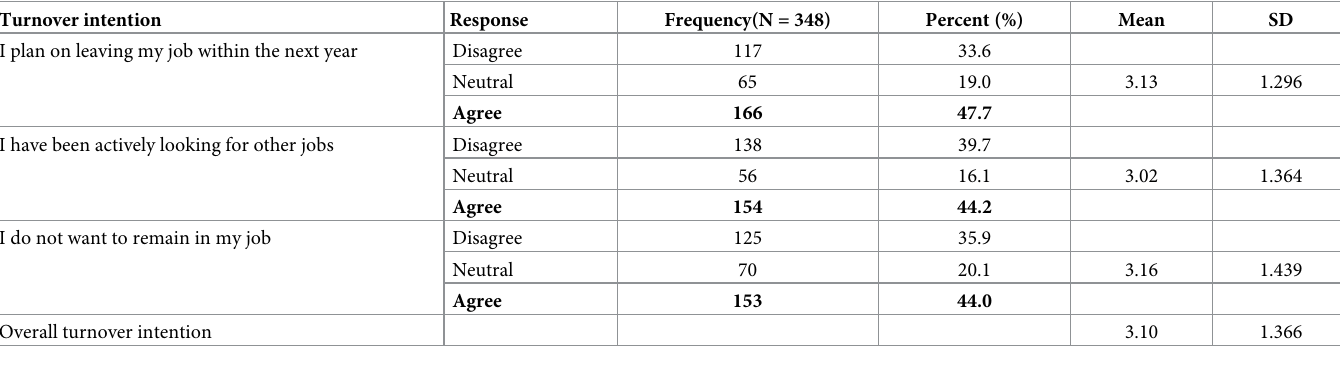
Table 3. Turnover intention among